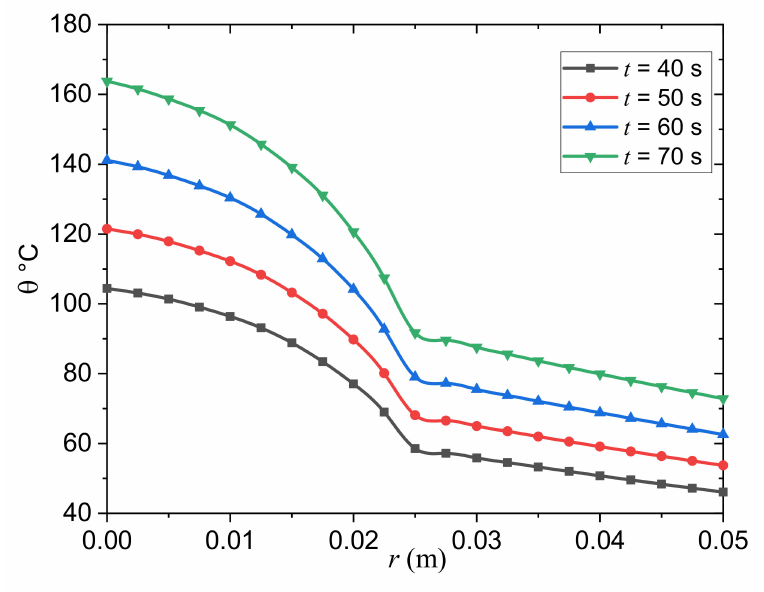
Figure 3. Effect of the instance time t on the temperature variation in the tumor and the normal tissues.